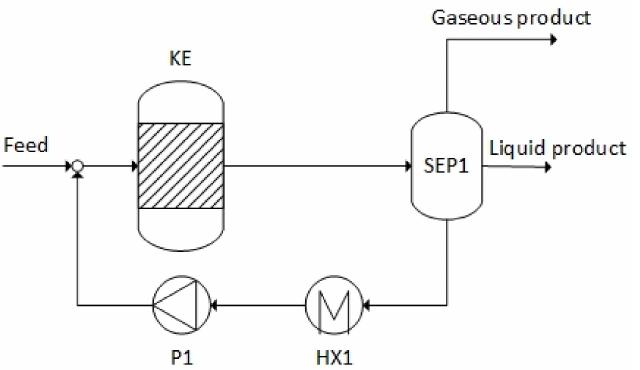
Figure 5. Process flow diagram for the production of docosane via Kolbe electrolysis (KE: Kolbe electrolysis, HX1: heat exchanger, SEP1: liquid–liquid–gas separation, P1: